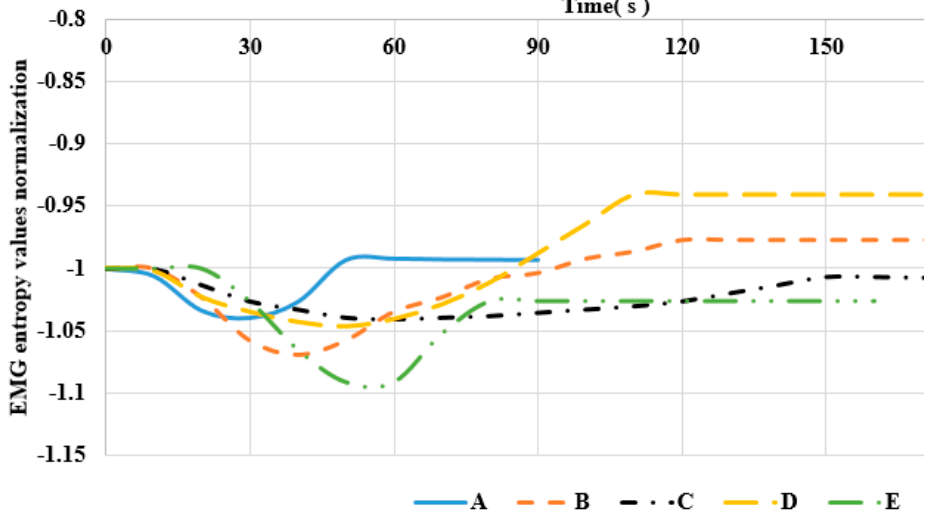
Figure 17. Comparison of entropy values of subjects under 18 kg load.